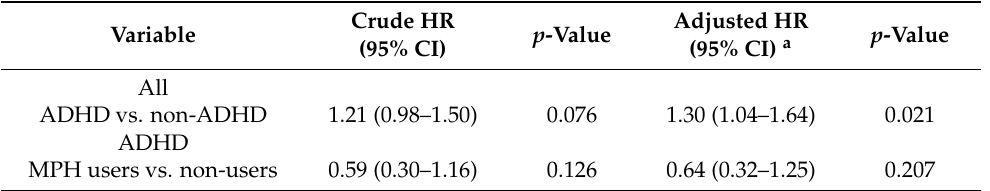
Table 2. Alopecia areata (AA) risk in children with and without attention-deficit/hyperactivity disorder (ADHD) and in children with ADHD receiving and not receiving